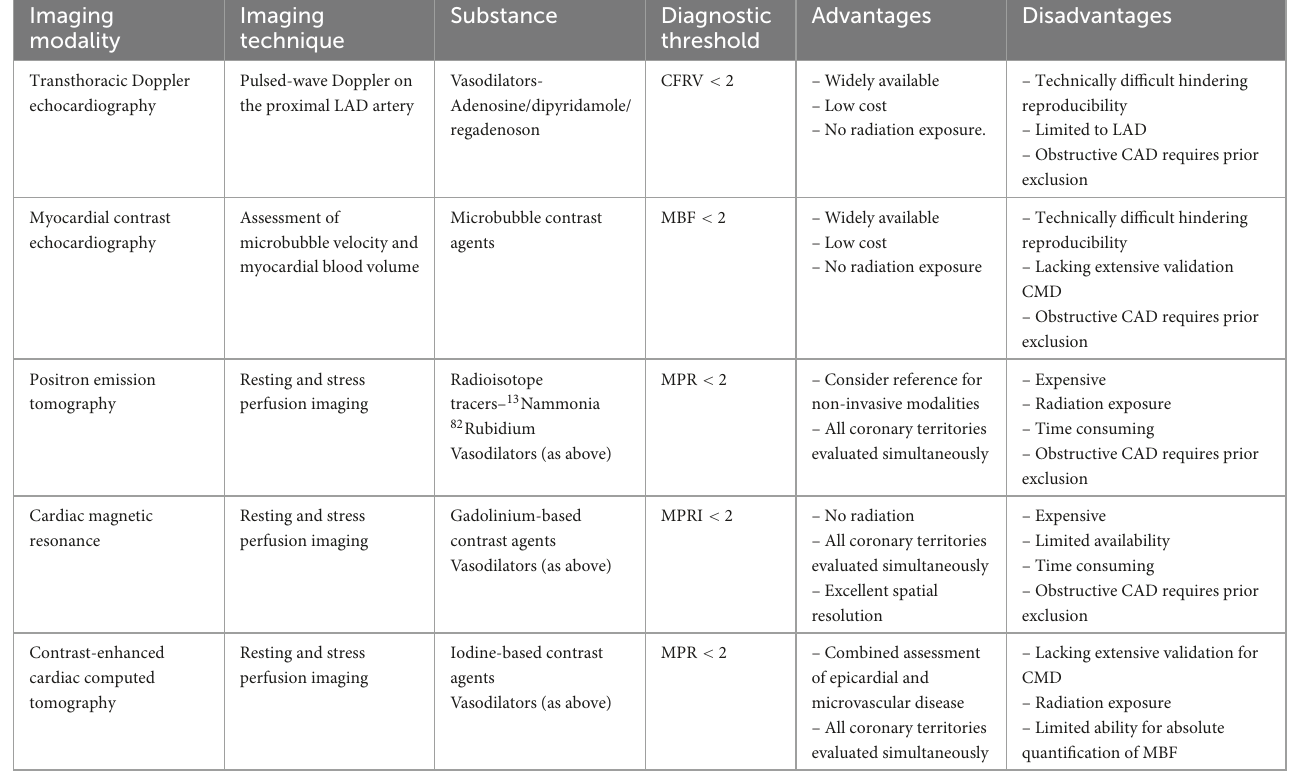
TABLE 1 Non-invasive diagnostic modalities for evaluation of the coronary